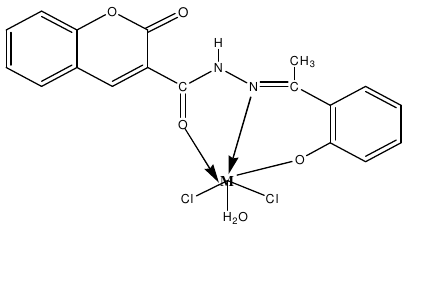
Figure 3 . Structure of complexes Figure 4 . Sturcture of